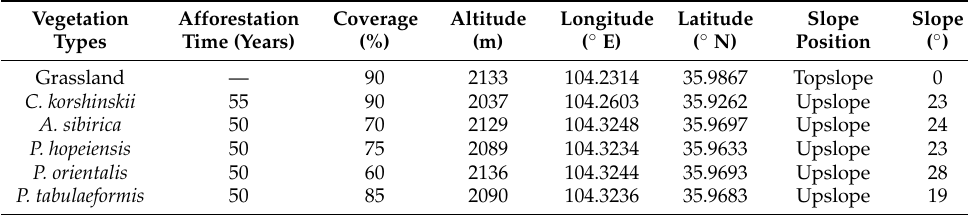
Table 1. Geographical characteristics of different vegetation types in the study